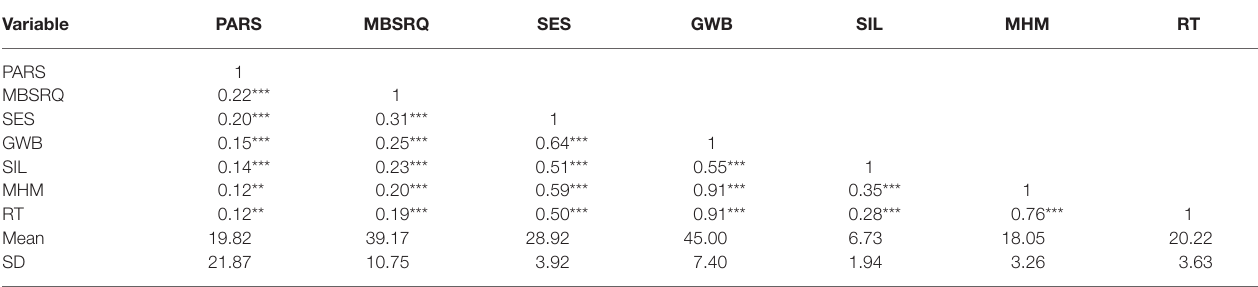
TABLE 2 | Descriptive statistics and the Pearson correlation coefficients across physical exercise, body image, self-esteem, and each dimension of subjective well-being in college students ( N = 671). Variable PARS